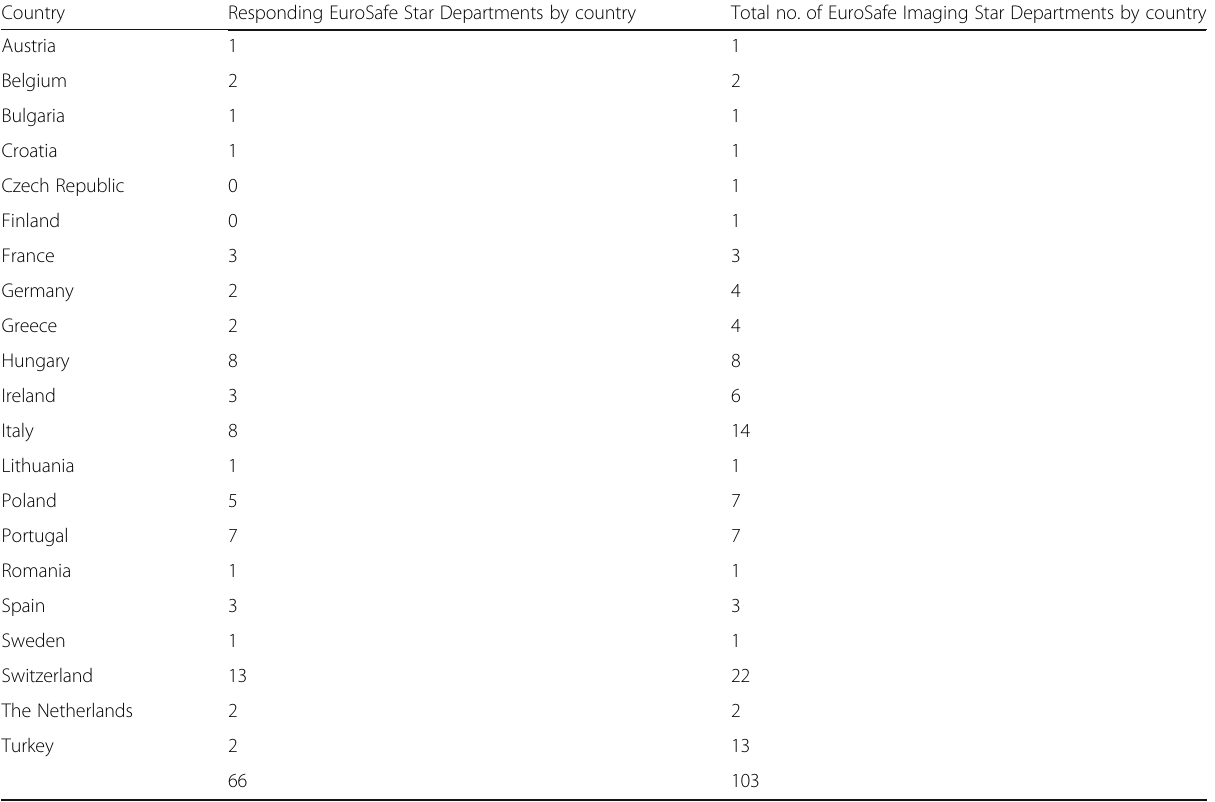
Table 1 Pilot Survey on uptake of European BSS Directive (2013/59 Euratom) requirements with particular focus on clinical audit in European radiology departments